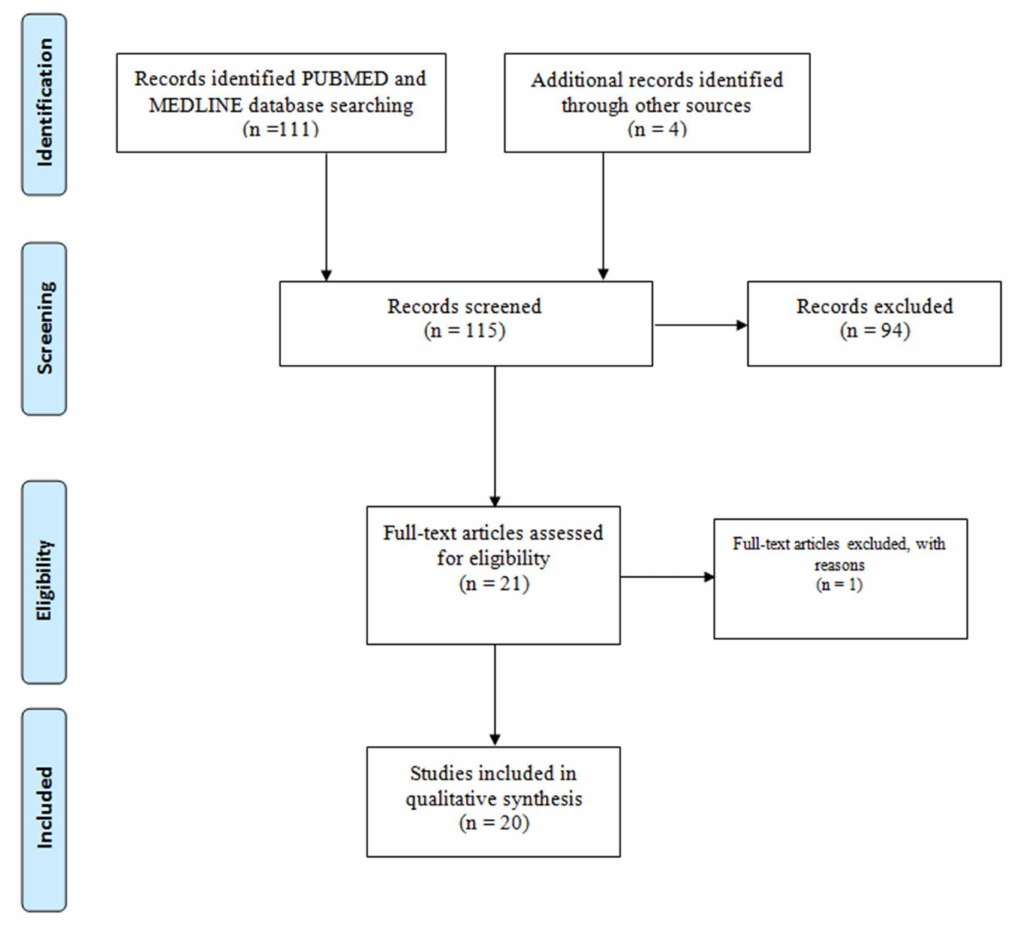
Figure 2. Preferred Reporting Items for Systematic Reviews and Meta-Analyses (PRISMA) flow chart showing the screening and retrieval process of publications that were eventually used in the